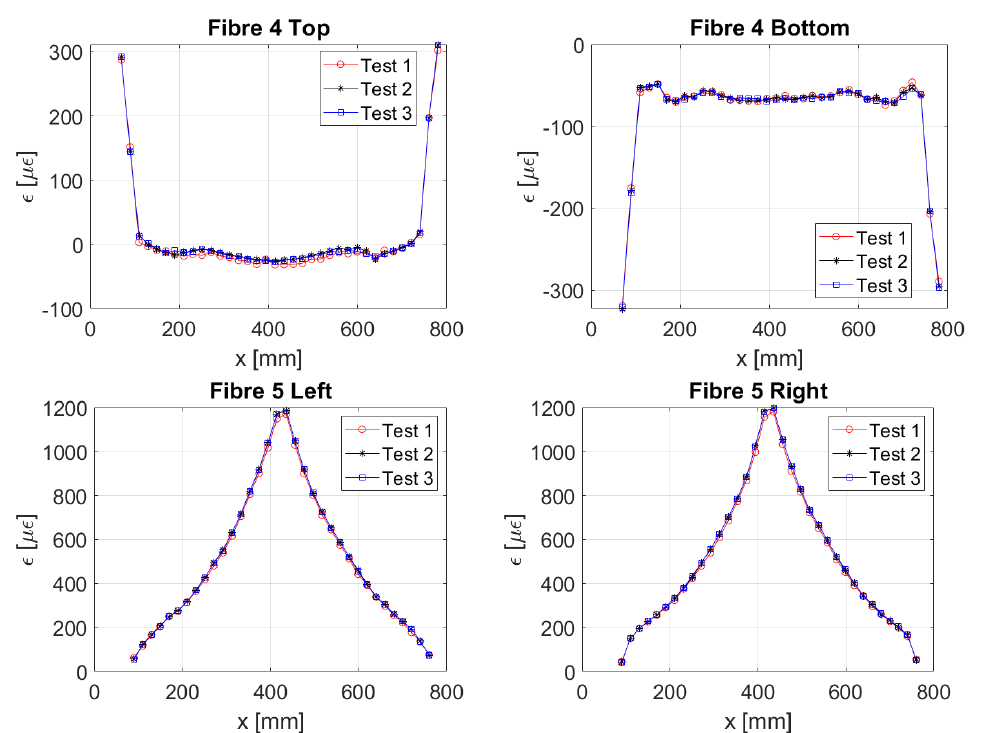
Figure A2. Experimental strains from the stiffened panel—The numbering of the fibres is the one reported in Figure